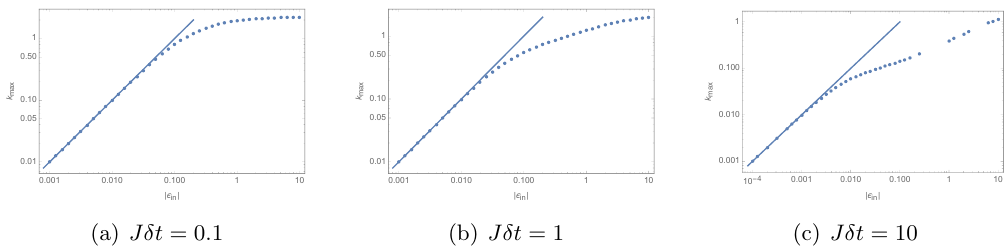
Figure 13 . Numerical evaluation of k max as a function of j (cid:15) in j for di(cid:11)erent values of J(cid:14)t . In the three cases, it is possible to observe a linear dependence of k max on j (cid:15) in j for small enough j (cid:15) in j . This is veri(cid:12)ed by the (cid:12)t with a function k max = c j (cid:15) in j (solid blue line). Further, we (cid:12)nd the coe(cid:14)cient c is the same in all three plots, i.e., it is independent of J(cid:14)t but depends, of course, on the choice of the threshold, being X ( k max ) = 0 : 1 in the present